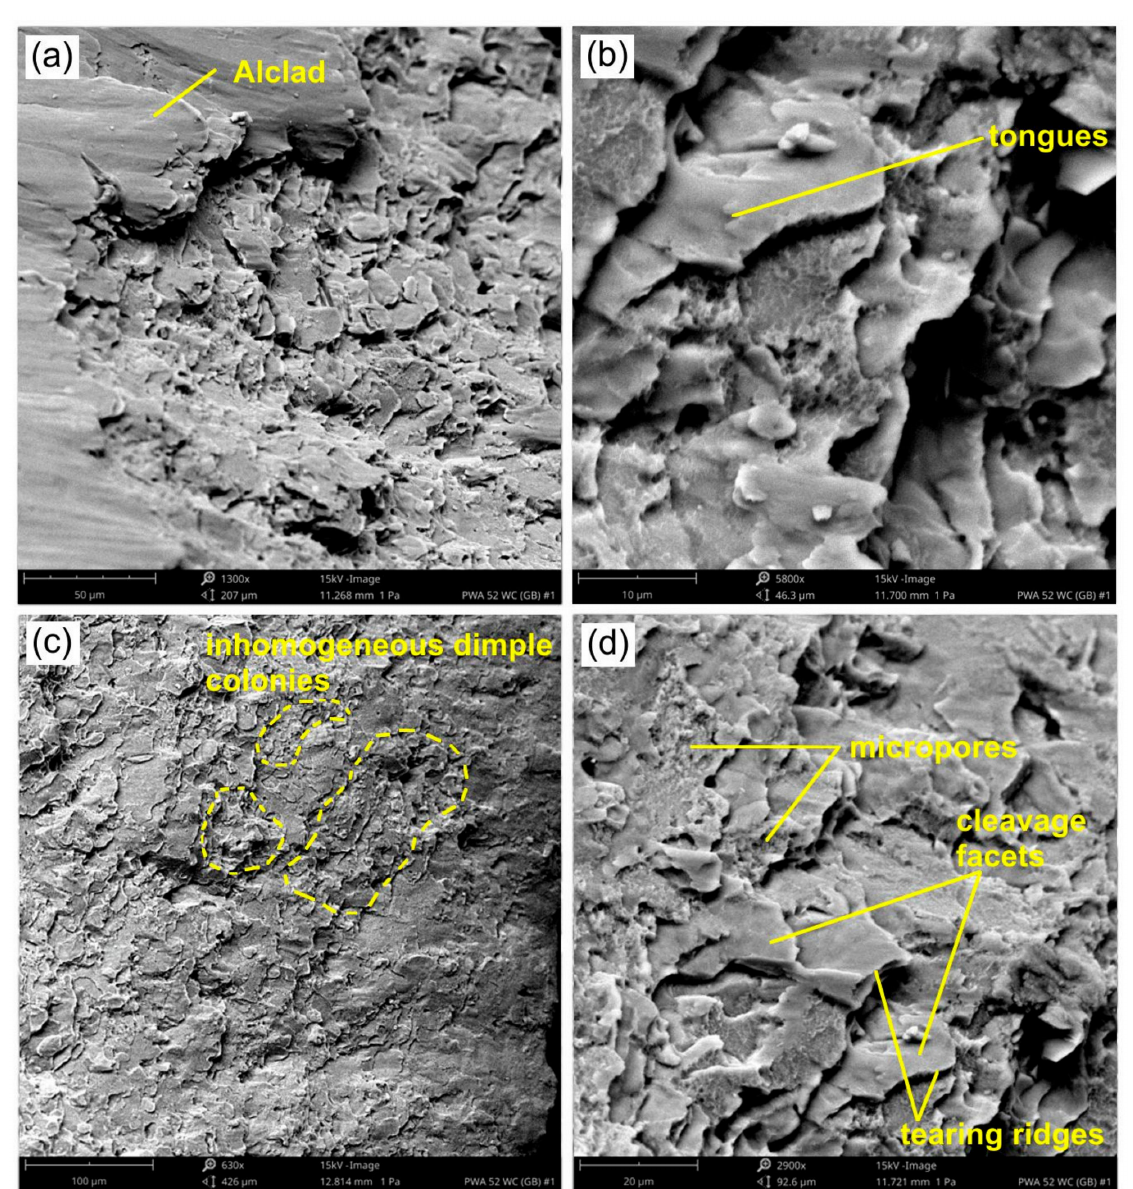
Figure 18. SEM micrographs of the fracture surface of a panel made of 0.8-mm-thick EN AW-7075-T6 Alclad sheet: Micrographs ( a – d ) show various fragments of the ductile